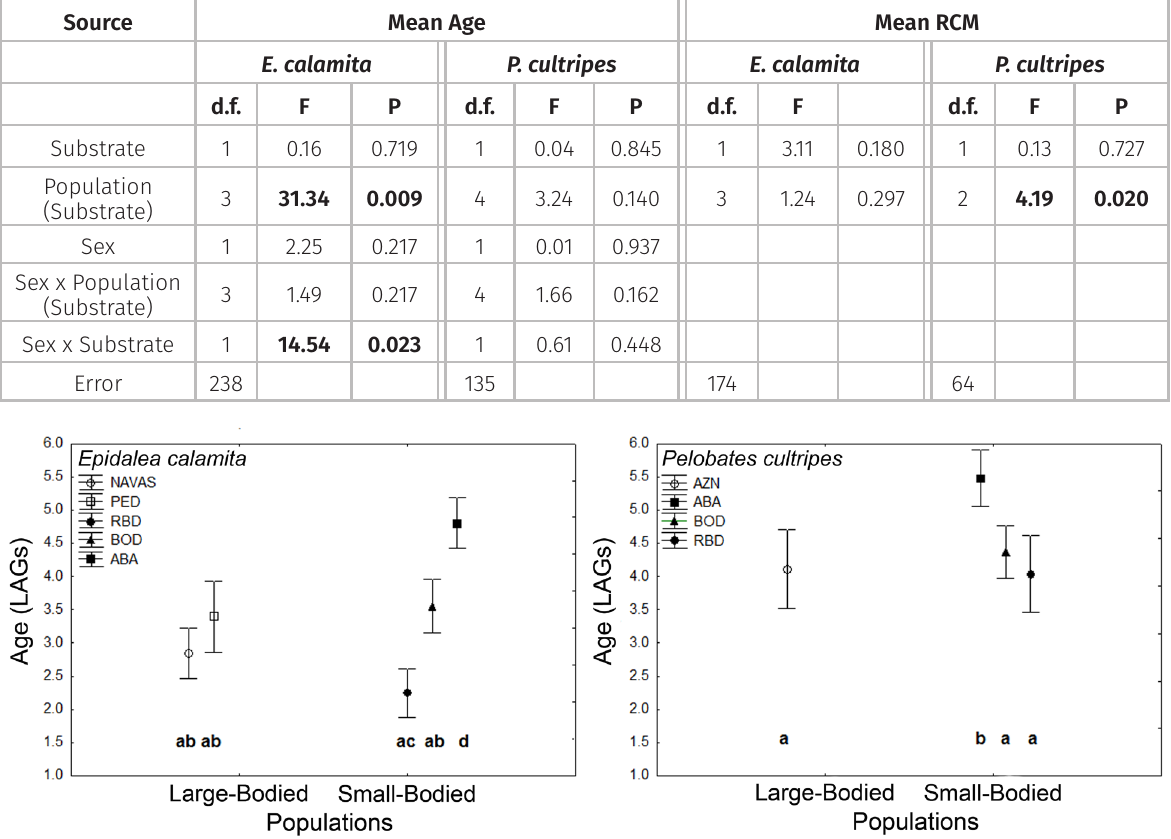
Table III. Results of two-way mixed model nested ANOVAs for responses of Epidalea calamita and Pelobates cultripes populations to substrate (Hercinic, Large-Bodied population vs Sandy, Small-Bodied populations), accounting for variation among sexes. Response variable are Mean Age and Relative Clutch Mass (RCM). Significant values are highlighted in boldface.